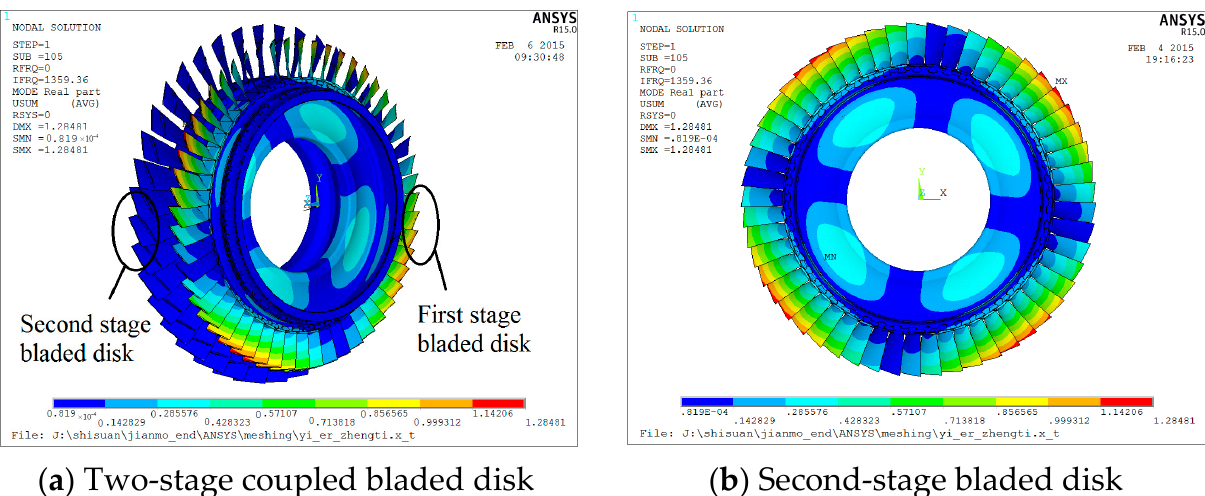
Figure 21. One-pitch coupled vibration of the blade and disk.